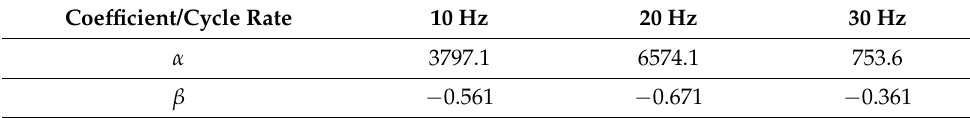
Table 7. Calculated values of α and β for the ASA+ material and given cycle